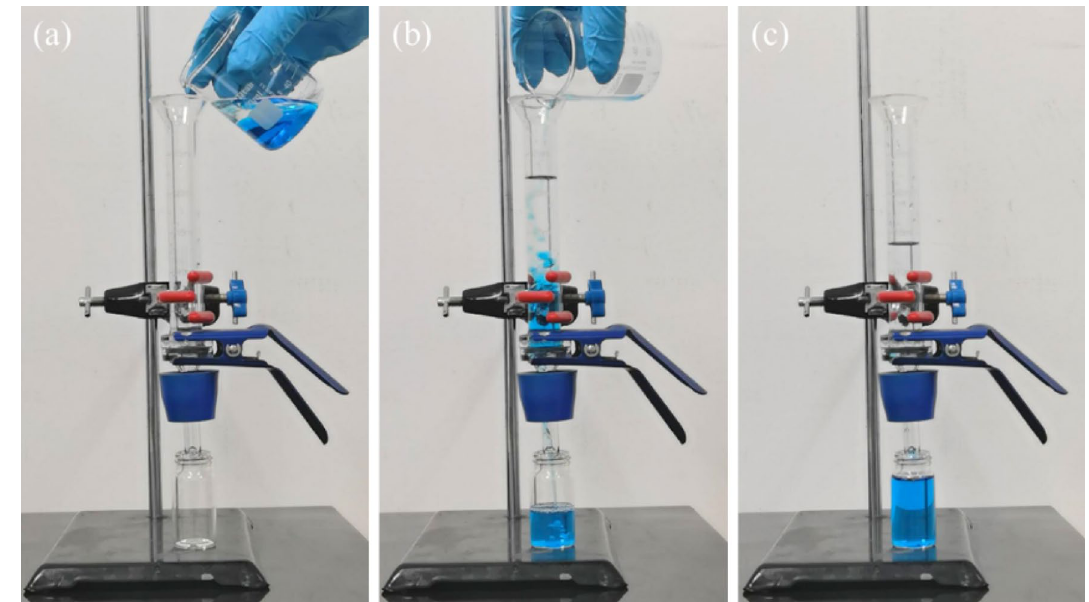
Figure 6. ( a – c ) Separation of n -heptane/dyed water